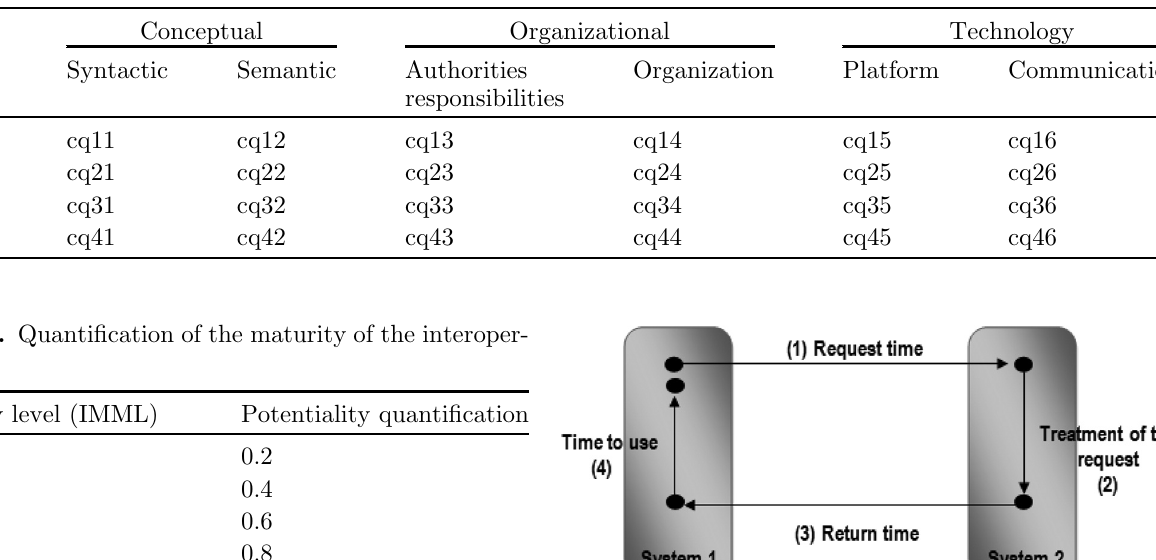
Table 1. Interoperability compatibility (proposed by [12]).